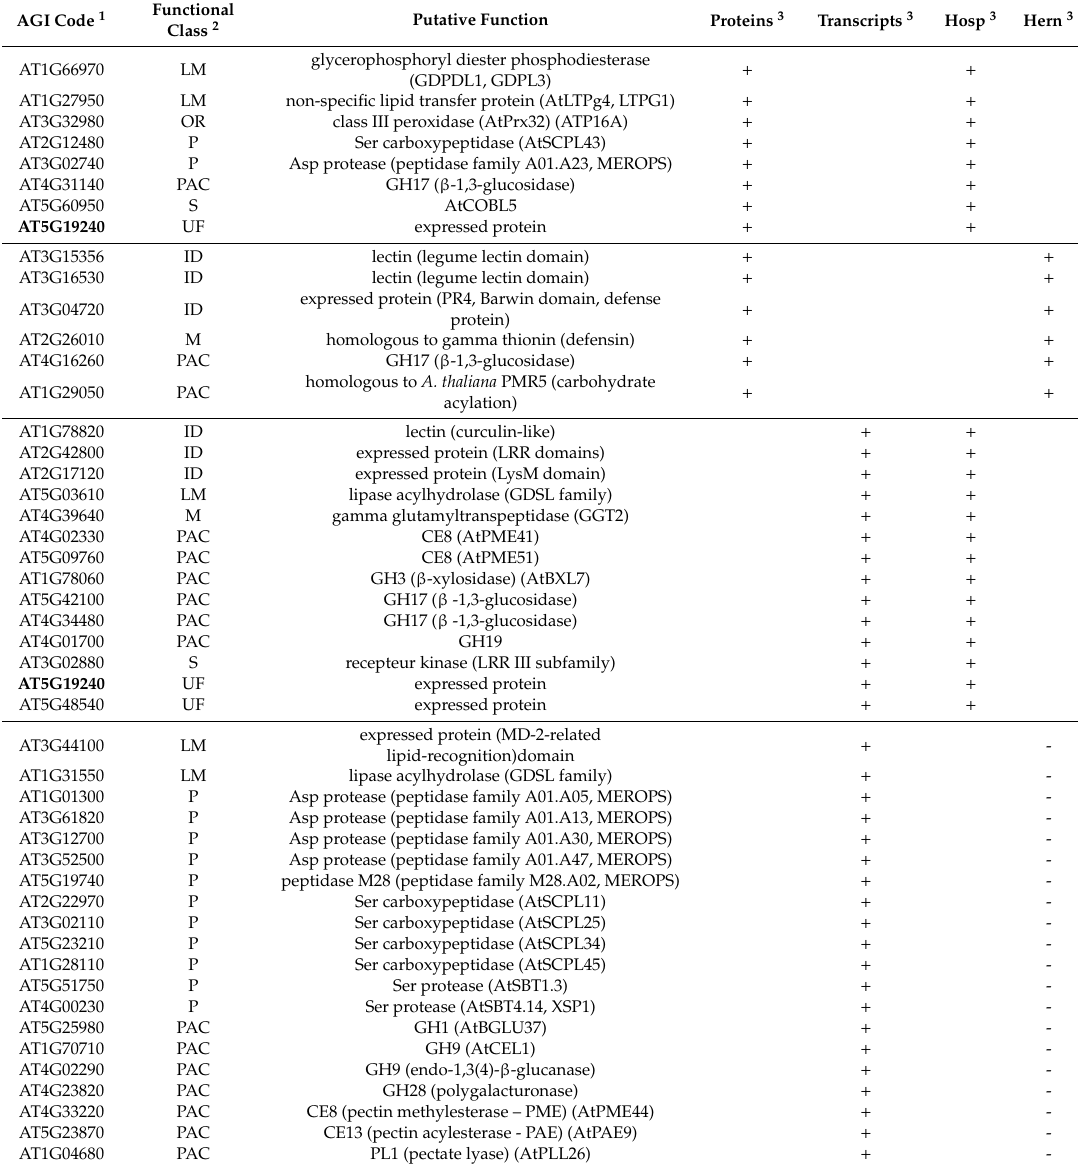
Table 5. Synopsis of CWPs or CW transcripts di ff erentially accumulated in floral stems of Hosp and